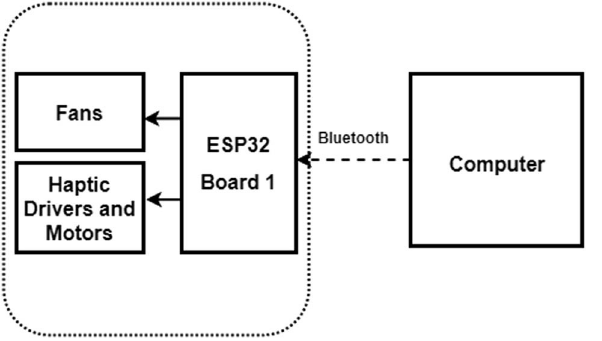
Figure 3: Block diagram with hardware components of the system and communication protocols.